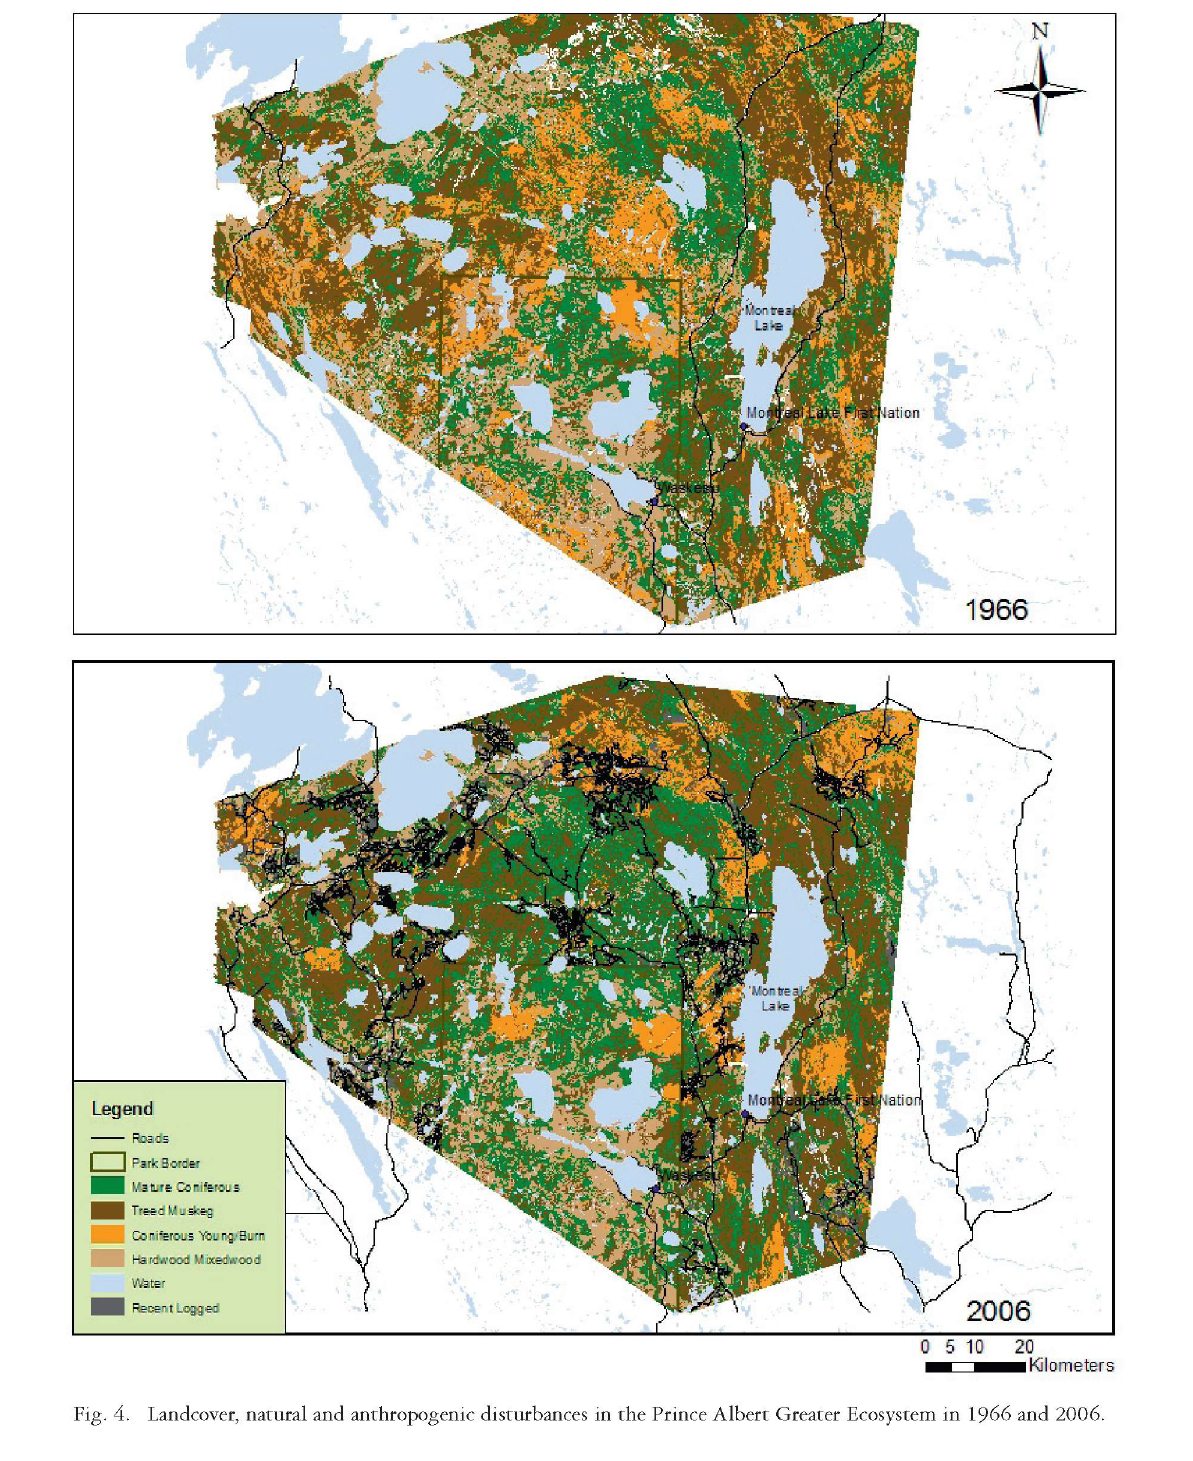
Fig. 4. Landcover, natural and anthropogenic disturbances in the Prince Albert Greater Ecosystem in 1966 and 2006.